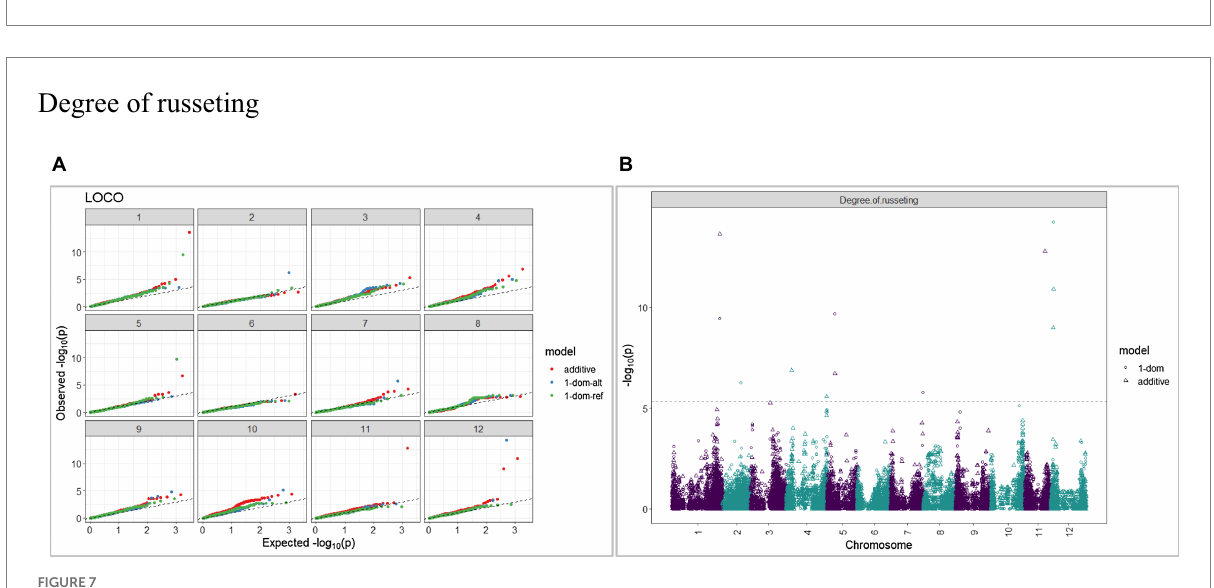
FIGURE 6 Q–Q plots of observed vs. expected -log10 ( p values) ( A ) and corresponding Manhattan plot (B) for tuber eye depth using the additive and dominant model for tuber traits of 214 potato clones evaluated in three environments in Texas: Dalhart 2019, 2020 and Springlake 2020. The Bonferroni threshold was at 5.3 for the additive, 5.0 for 1-dom-alt, and 5.1 for the 1-dom-ref model.